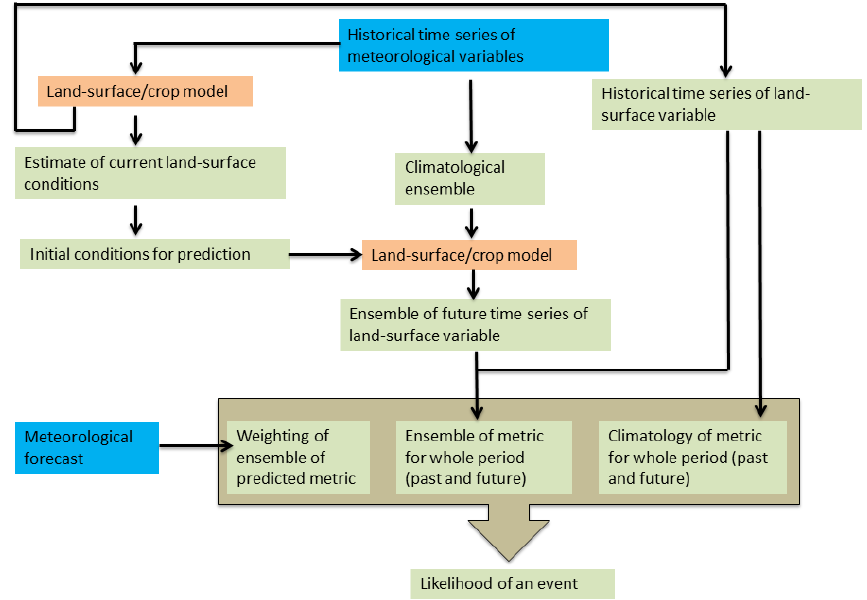
Figure 1. Conceptual overview of the TAMSAT-ALERT system. The blue boxes represent input data sources, the orange boxes represent the processes involved in the system and the green boxes show the outputs from TAMSAT-ALERT